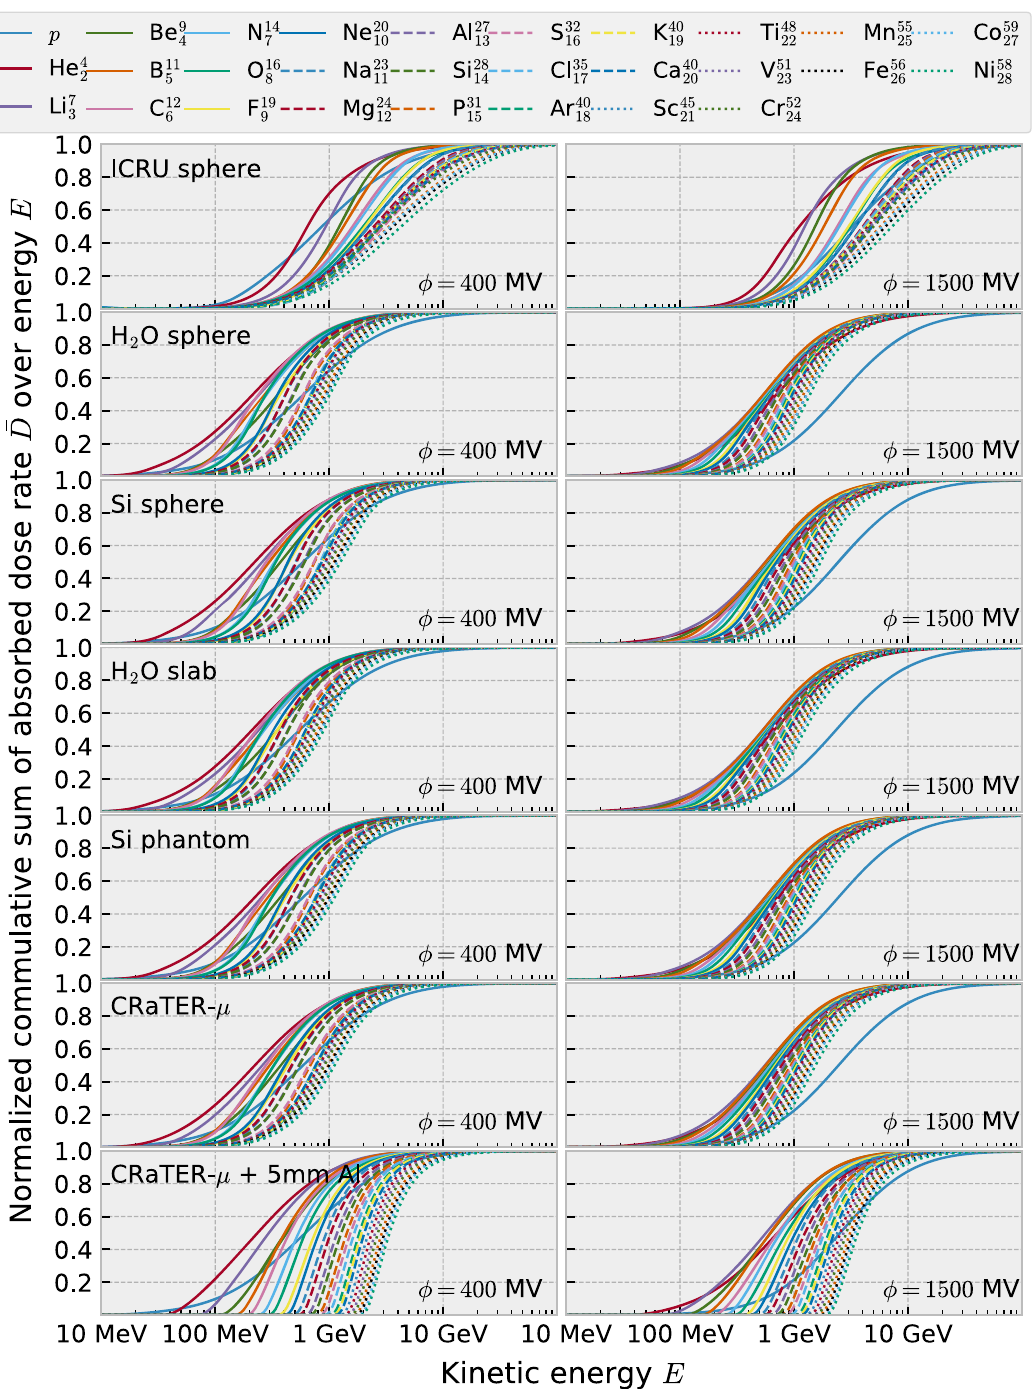
Fig. A2. The normalized cumulative sum of absorbed dose over kinetic energy has been calculated for (i) the seven detectors and (ii) the two cases of solar activity, to each corresponding a separate fi gure panel (look at the upper corners). Each panel contains the 28 cumulative sums corresponding to the absorbed dose rates due to different GCR nuclei. We see that the energy range between 100 MeV and 100 GeV is where GCR are suf fi ciently abundant and/or are particularly effective at depositing signi fi cant ionization energy to the